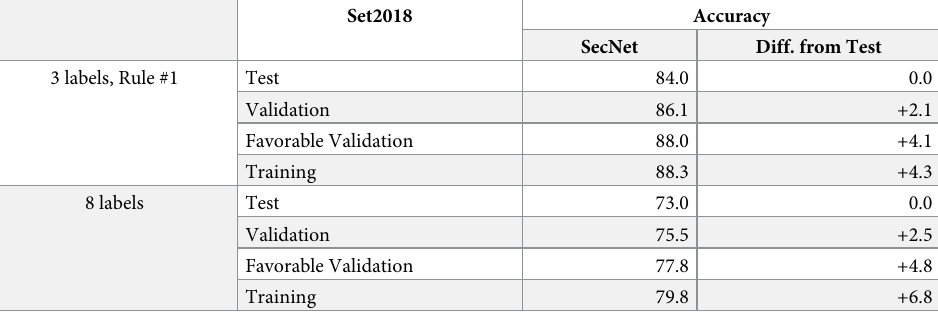
based on the highest validation accuracy, we gain additional 2.3 and 2.0 point improvements Table 8. Evidence of prediction accuracy overestimation of SecNet on Set2018 validation and training sets relative to the test set.